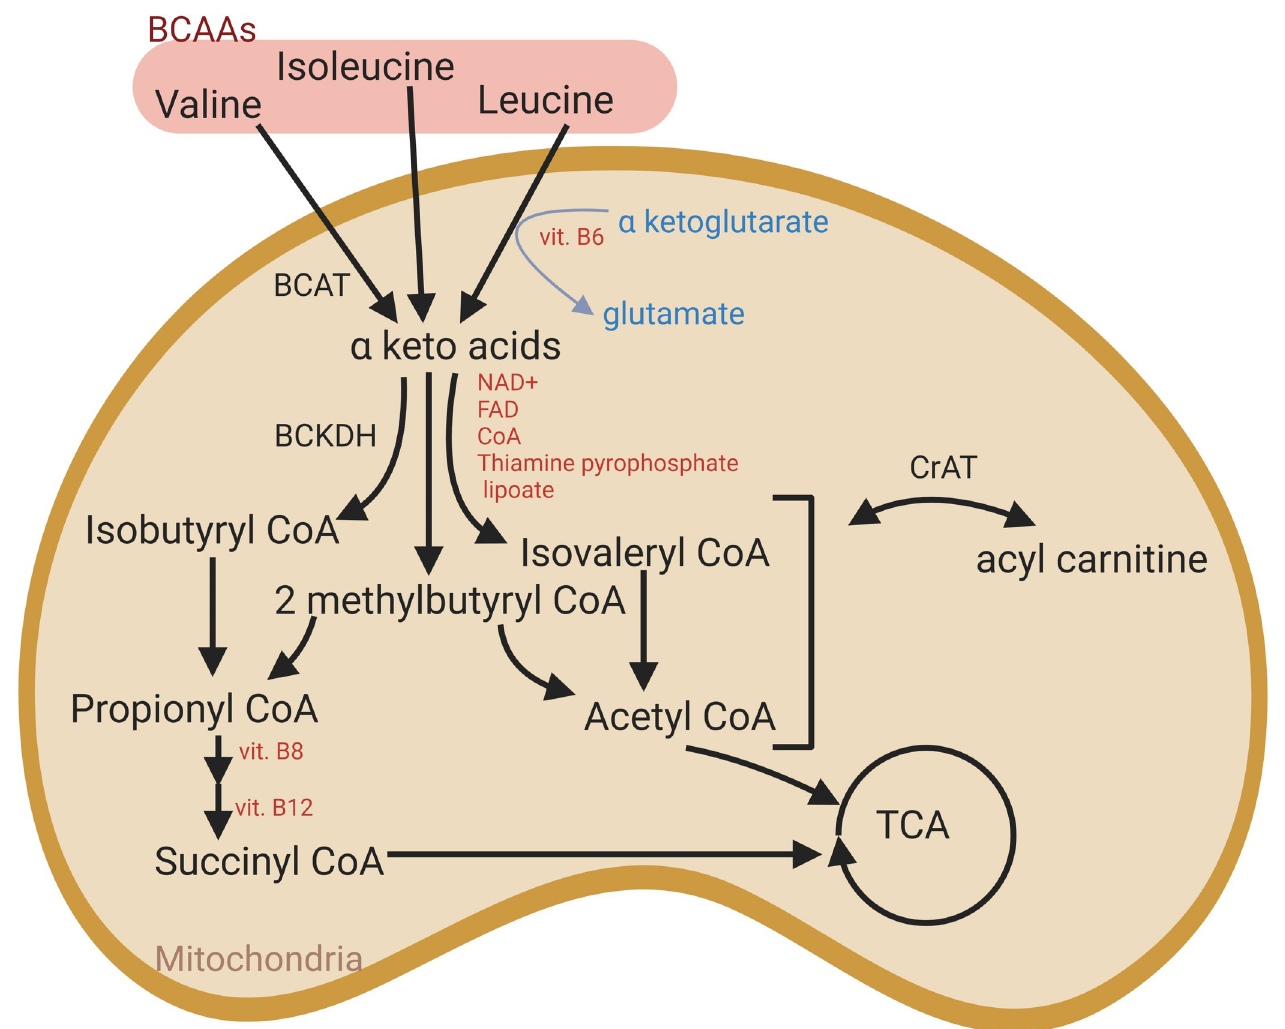
Fig 2. Branched-chain amino acid metabolism (BCAA) in muscle mitochondria. Intermediates derived from alternative pathways can feed into the TCA cycle. BCAT: branched-chain amino acid aminotransferase; BCKDH: branched-chain keto-acid dehydrogenase complex; CrAT: carnitine acetyltransferase.